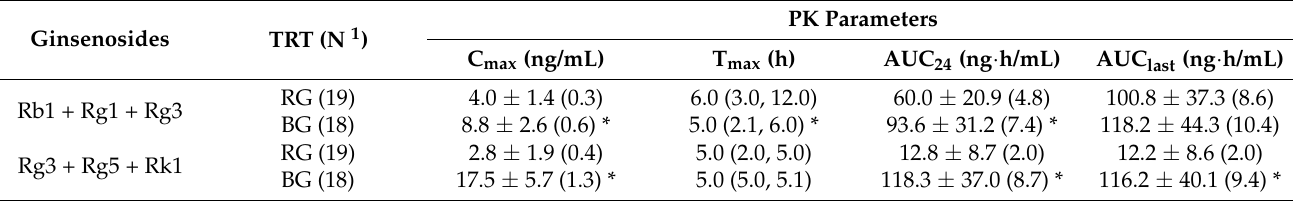
Table 2. Pharmacokinetic (PK) parameters of functional ginsenoside groups in healthy male volunteers after a cross-over administration of black ginseng (BG) and red ginseng (RG).